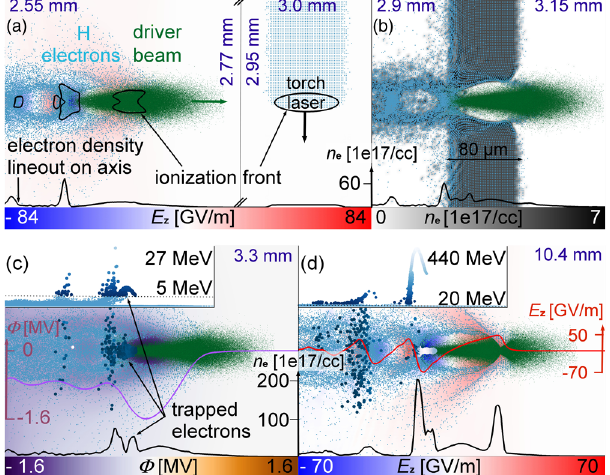
FIG. 3. Optical plasma torch injection for case (i). In (a) the plasma torch is generated in the path of the drive beam, and in (b) the torch is crossed, leading to blowout amplification and injection. The injected hydrogen electrons are shown in (c) and (d) after z ≈ 10 . 4 mm of acceleration, where maximum energies of E ≈ 440 MeV are